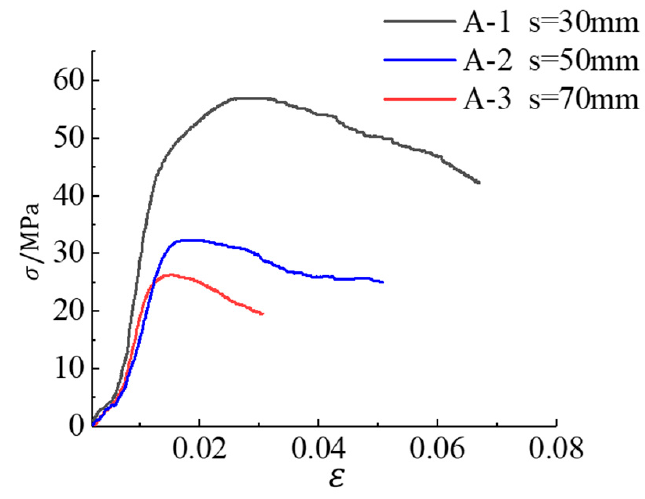
Figure 4. Influence of stirrup